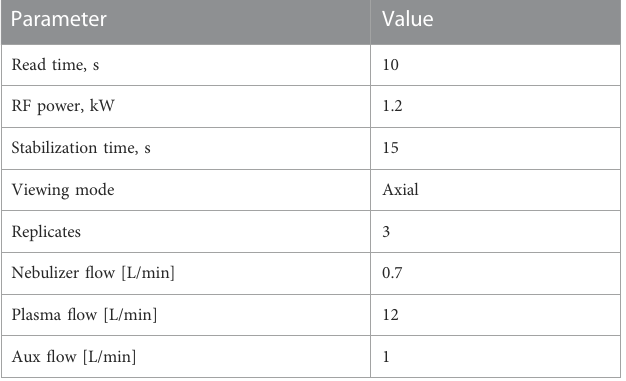
TABLE 2 Operating parameters for Agilent 5110 ICP-OES